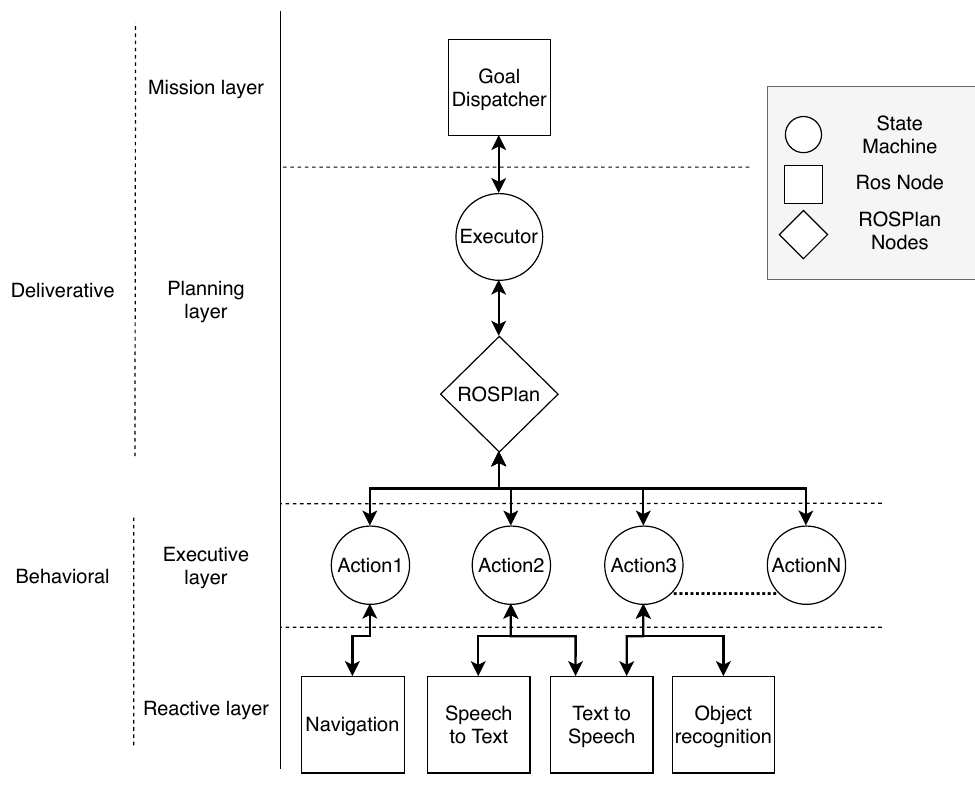
Figure 1. Proposed architecture.